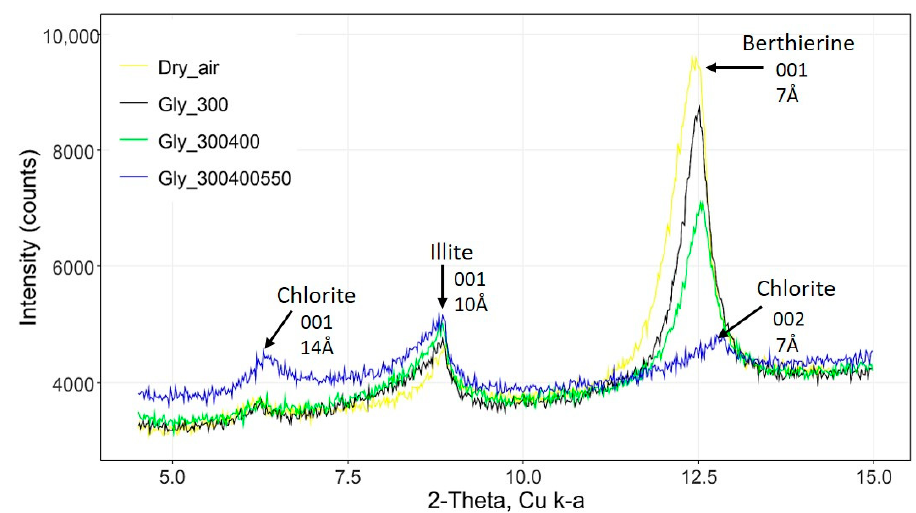
Figure 13. Various XRD traces from an Fe-rich clay-bearing samples from BL5 (2200.9 m MD) following various pre-analysis treatments: air-drying, glycolation followed by heating to 300 ° C, 400 ° C and 550 ° C to investigate Fe-clay types. The X-ray peaks show mineralogy with the separation showing reduction in peak intensity for Fe-clay, diagnostic of berthierine.